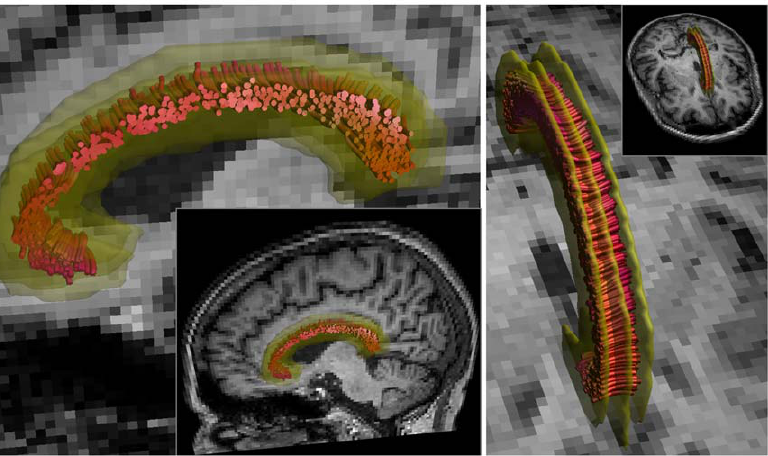
Figure 2. Selection of the medial segment of the corpus callosum (CC). The CC was selected using a multiple region of interest (ROI) approach. The median ROI was placed on the midsaggital plane in MNI space, and the two segment-selecting ROIs were drawn two voxels (4 mm) to either side of the midsagittal plane.